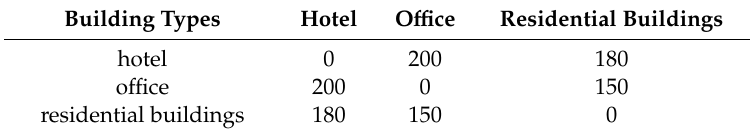
Table 1. Distance between buildings (m).